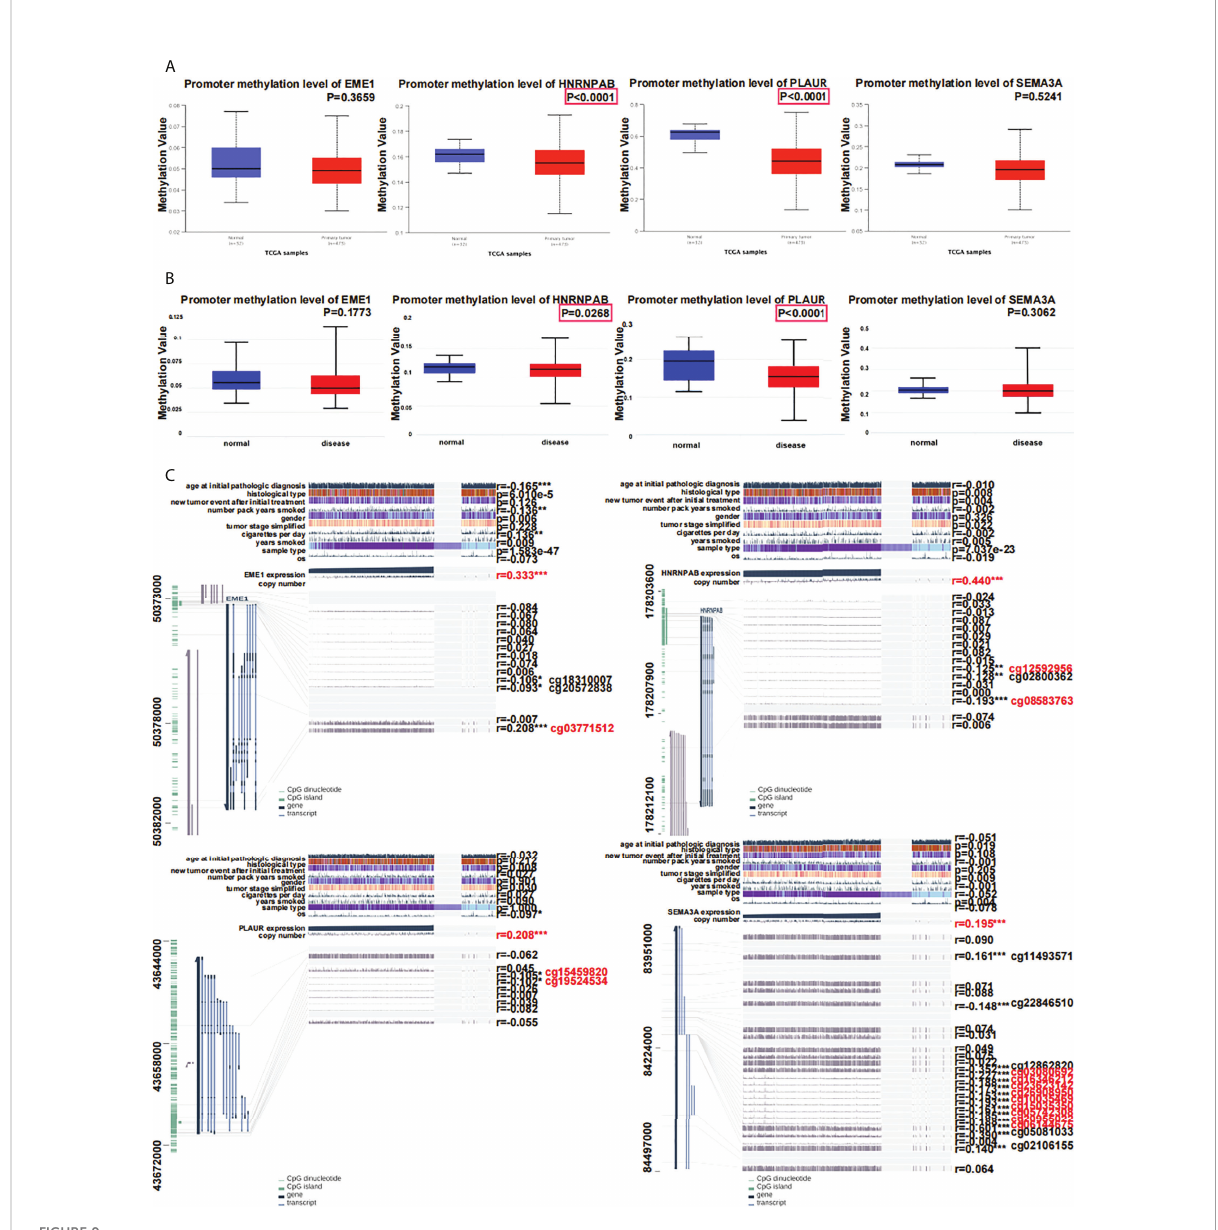
FIGURE 9 Relationship between predicted target gene expression and methylation. (A) Evaluation of methylation on UALCAN. (B) Evaluation of methylation with DiseaseMeth.qqqqqqqqqq (C) The methylation sites of DNA sequence association with gene expression. *p < 0.05; **p < 0.01; ***p <